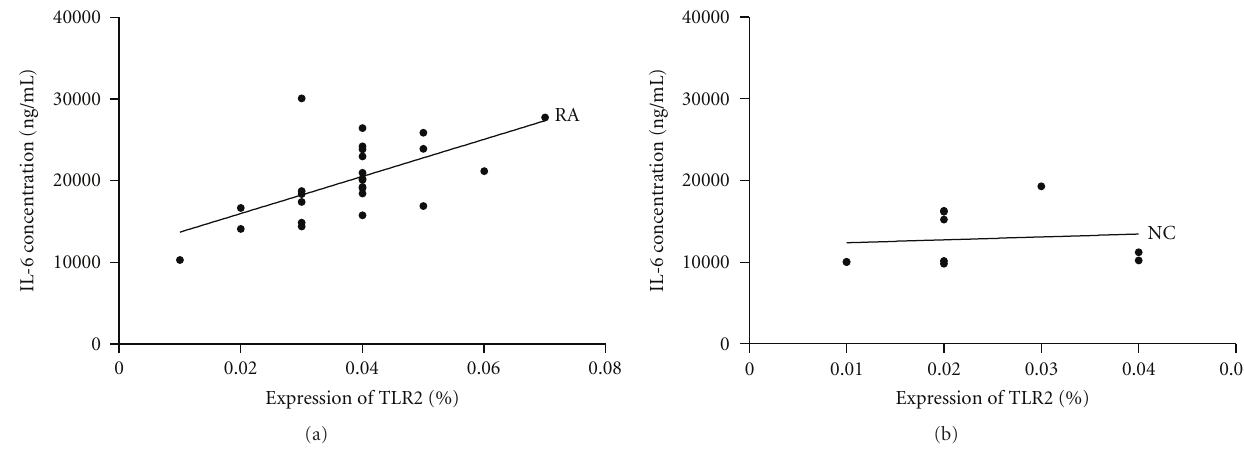
Figure 6: Relationship between IL-6 concentration and TLR2 expression (calculated as percentage of CD14 + monocytes expressing TLR2) in monocytes after stimulation with 10 μ g/mL of peptidoglycan in RA patients and normal controls (NC). (a) In RA patients, TLR2 expression was significantly correlated with IL-6 concentration ( r = 0 . 611, P = 0 . 001); (b) no correlation in normal controls ( r = 0 . 449, P = 0 .